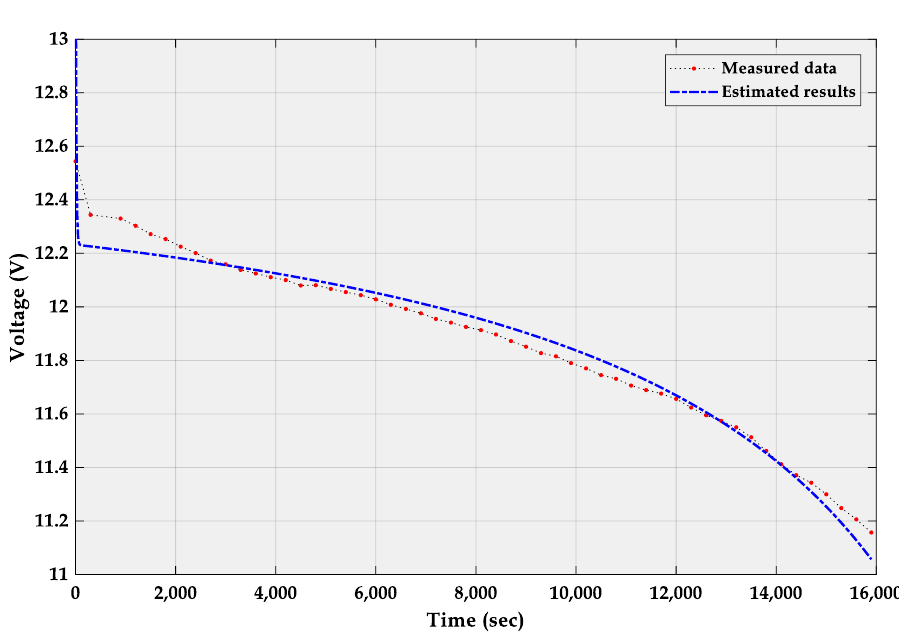
Figure 11. Measured and estimated voltage